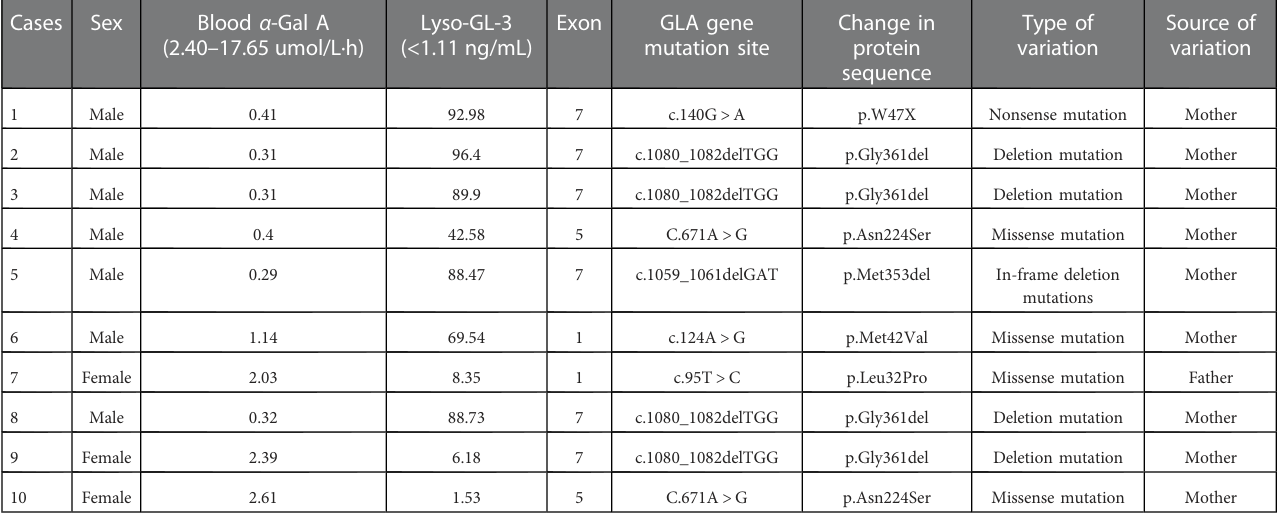
TABLE 3 FD-speci fi c indexes and GLA gene in children with Fabry disease.